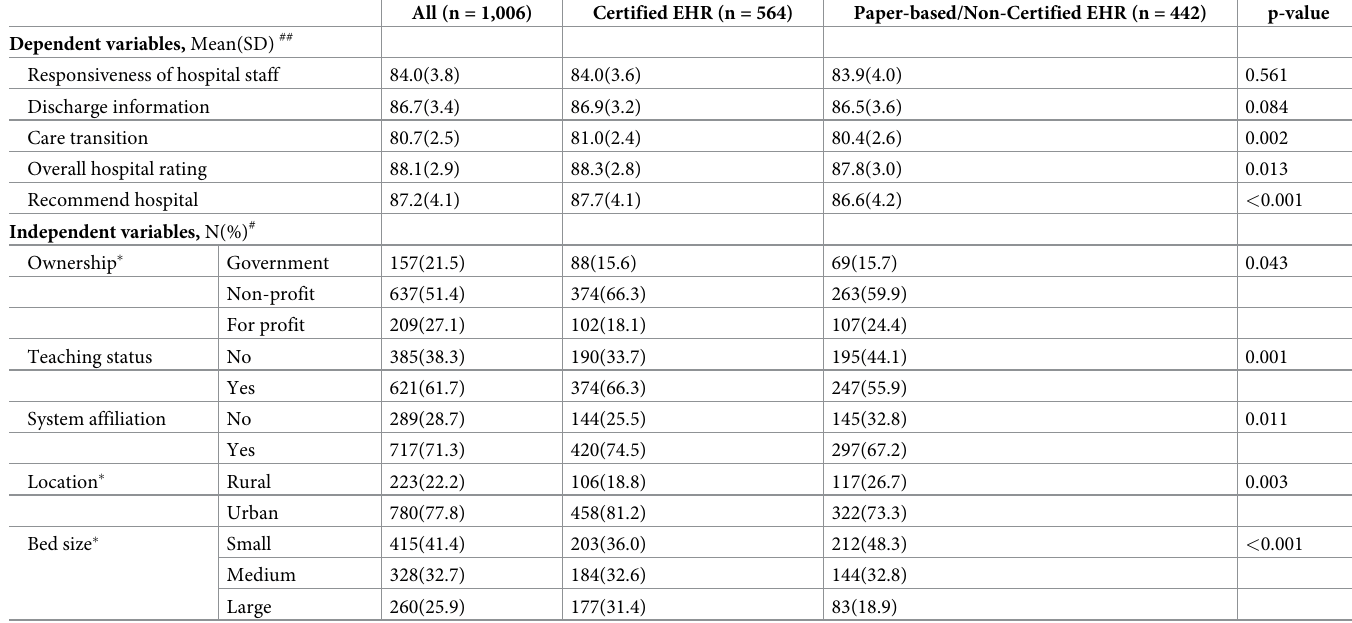
Table 1. Hospital characteristics by EHR